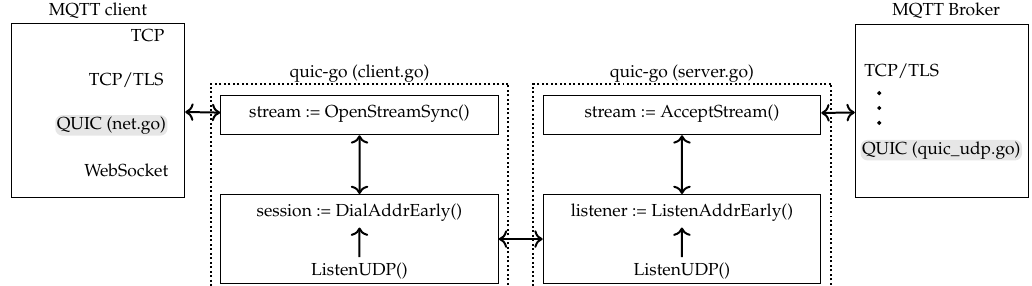
Figure 3. Implementation scheme of QUIC socket in